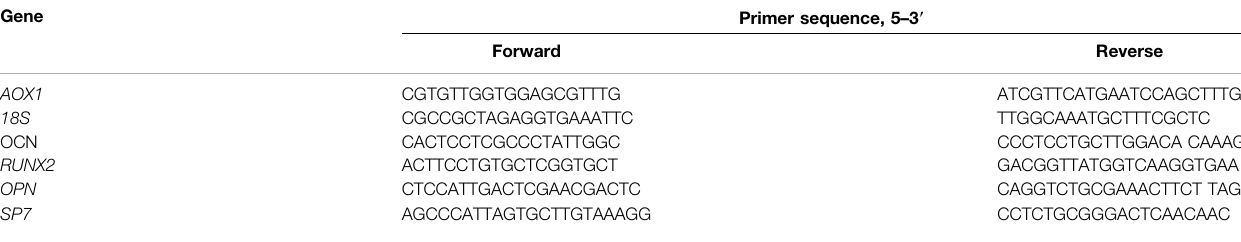
TABLE 1 | Sequences of primers for real-time quantitative PCR